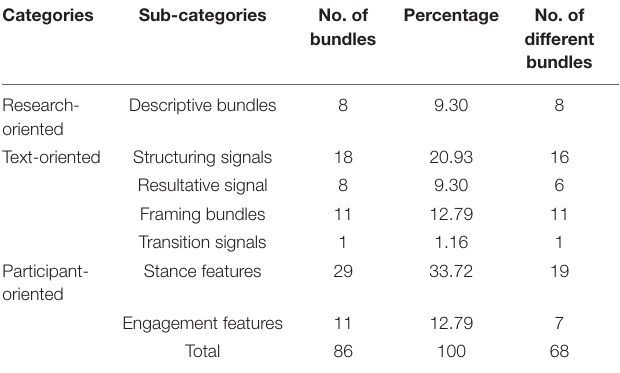
TABLE 3 | Functional categories in results and